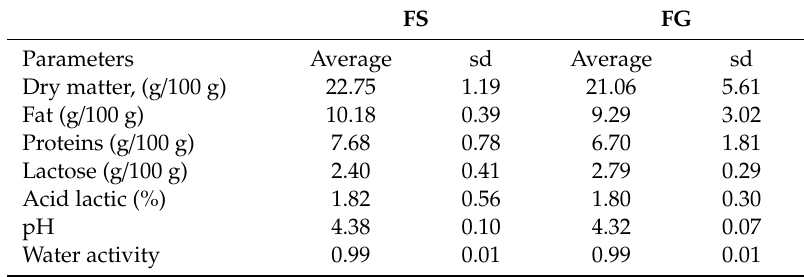
Table 1. Physicochemical parameters of Fruhe cheese produced with sheep (FS) and goat milk